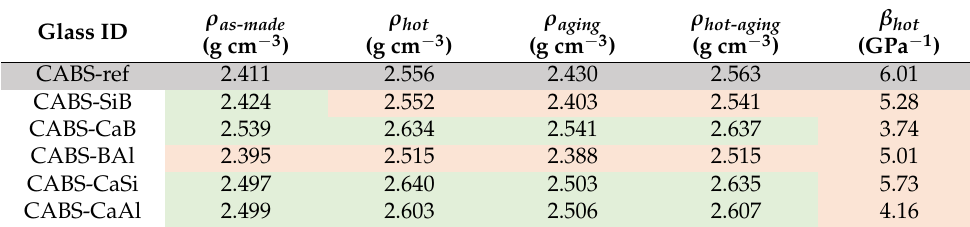
Table 2. Density ( ρ ) of the as-made, hot-compressed, humid-aged, and hot-compressed/humid- aged CABS glasses. Plastic compressibility ( β hot .), i.e., the relative increase in density upon hot compression, is also given. Coloring indicates density or plastic compressibility value of reference glass or within ± 0.2% (grey), increasing density or plastic compressibility relative to reference (green), and decreasing density or plastic compressibility relative to reference (red). The error in density was within ± 0.002 g cm − 3 .